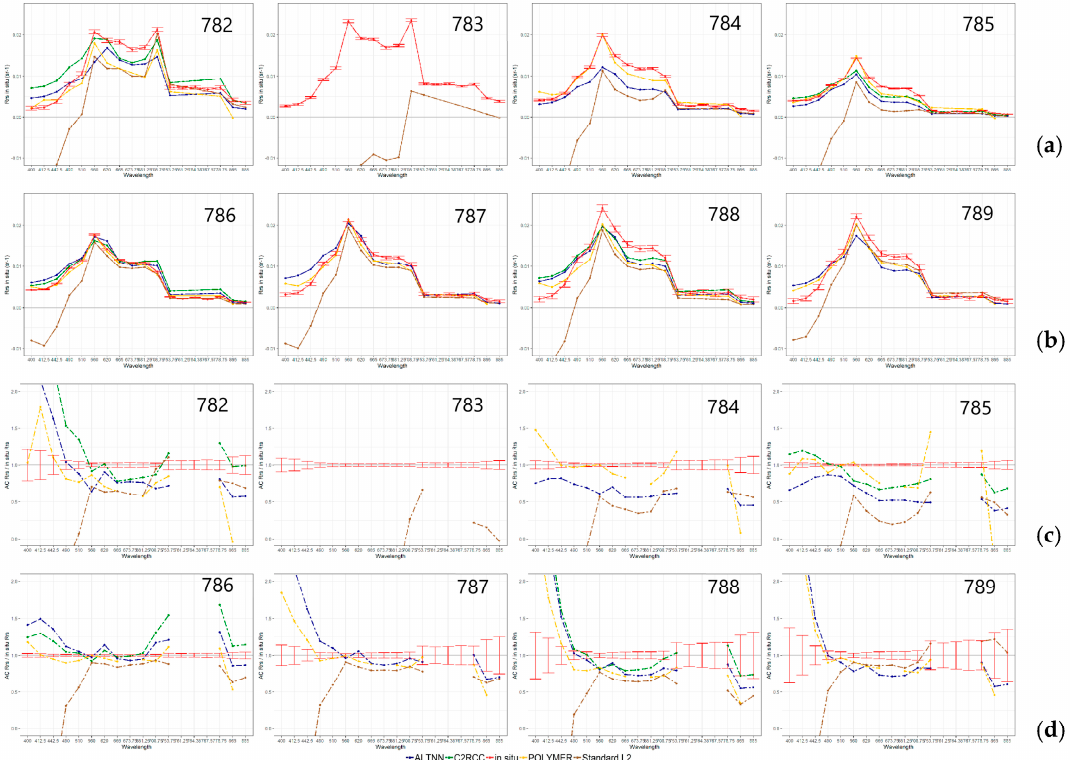
Figure 5. The comparison of in situ and atmospheric correction (AC) processor-derived R rs ( a , b ) and the ratio of the AC-derived R rs to the in situ measured R rs ( c , d ) in 8 match-up stations on 14 June 2016. Red error bars show the uncertainty derived from in situ measurements. For each point (ID 782 – ID 789 in Table A2), the changes in the sky conditions, the temporal and spatial changes in the measurement conditions and the optical properties of water can be found in Figure